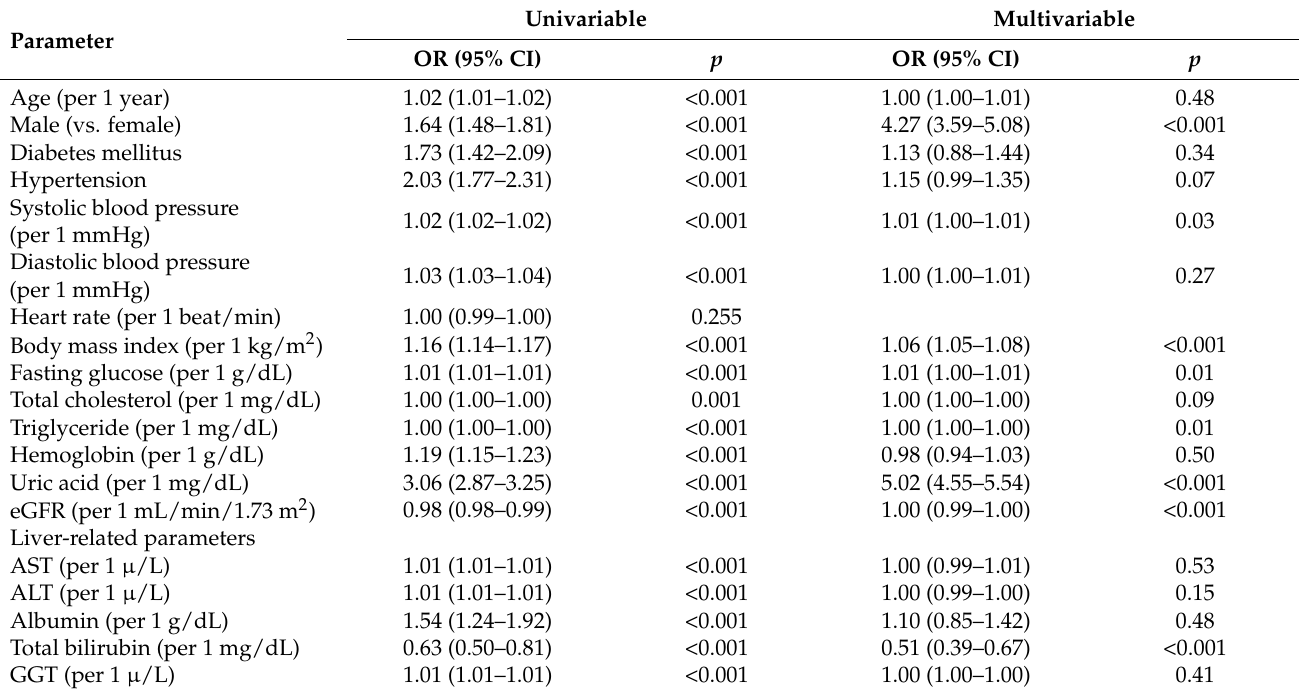
Table 3. Determinants of new-onset hyperuricemia using binary logistic analysis in 20,303 study participants with normal total bilirubin ( ≤ 1.2